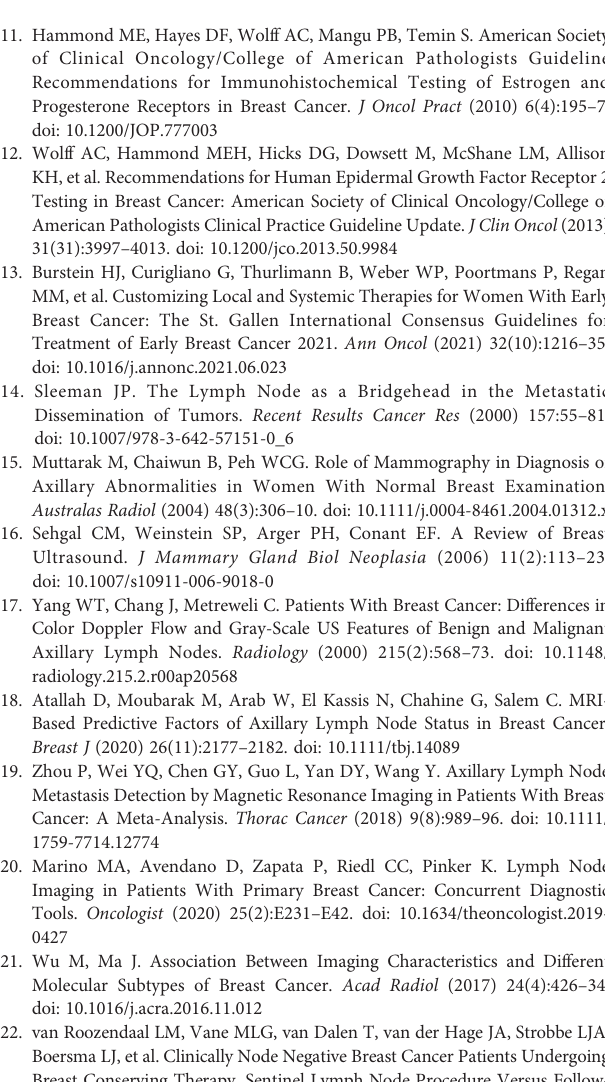
Supplementary Figure 1 | Flowchart of the patient selection process in this study. Supplementary Figure 2 | Morphological features of mammograph that are predictors of lymph node malignancy. Size>2cm (A, C) , increased density (B) , rounded or irregular shape (B, D) , spiculated margins or the absent fatty hilum). Supplementary Figure 3 | Ultrasonic morphological features that can predict lymph node malignancy. Focally or diffusely thickened cortex (> 3 mm thick) (A, B) , deformed or absent fatty hilum (C, D) , abnormal blood fl ow (B, D) . Supplementary Figure 4 | Morphological features of MRI that can predict lymph node malignancy. Irregular contour compared with the contralateral axilla (A – C) , node measuringgreaterthan1cm (A,B ,thickenedcortex>3mm (A,B) ,thelossoffattyhilum (C) Supplementary Figure 5 Ethics